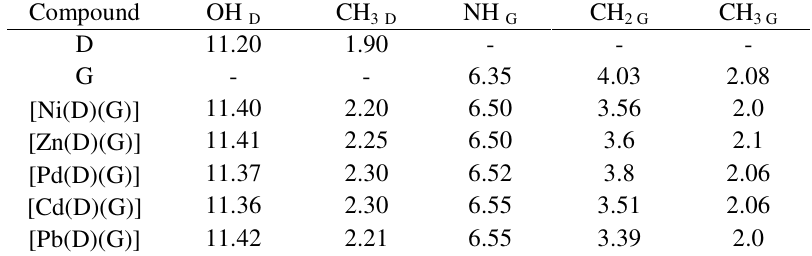
Table 3. 1 H NMR chemical shifts ( δ , ppm) of the free ligands and their complexes